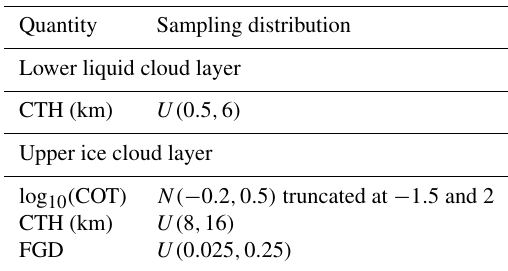
Table 5. Sampling of geophysical parameters for multi-layer (ice above liquid) cloud simulations. Quantities not given here are as in Tables 2 and